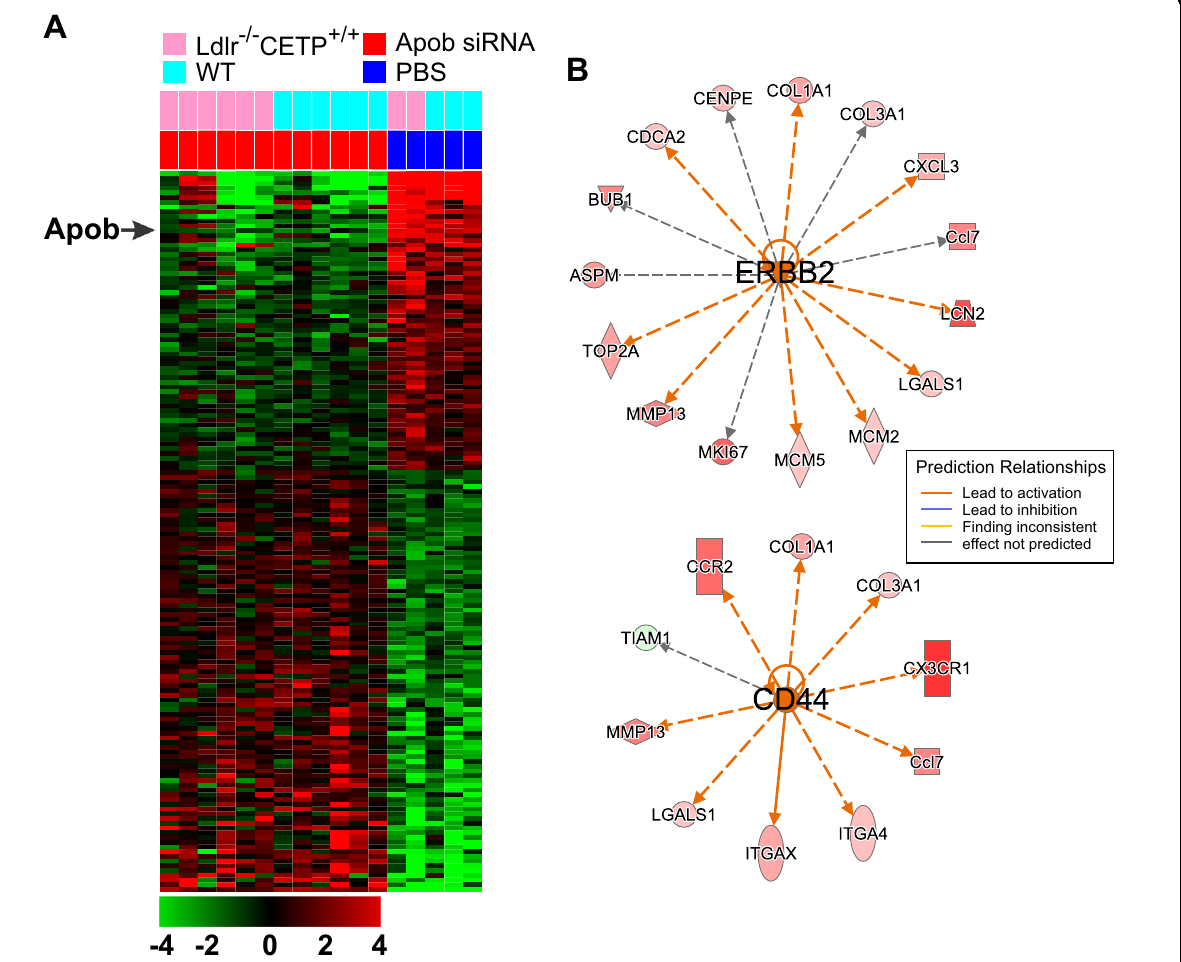
Fig. 1 Apob-associated gene expression signature in mouse livers. a Gene expression data were collected after treatment of mice with two siRNAs speci fi c for Apob or with phosphate-buffered saline (PBS) as the control. The expression of 152 genes was signi fi cantly altered (1.5-fold difference, P < 0.005) by silencing of Apob expression in mouse livers regardless of the genetic background and difference in siRNAs. Ldlr − / − CETP + / + indicates mice with the Ldlr − / − mutation and the human CETP + / + transgene under the human APOA1 promoter. WT indicates wild type. The data are presented in matrix format in which rows represent individual genes and columns represent tissue. Each cell in the matrix represents the expression level of a gene feature in an individual tissue. Red re fl ects relatively high expression and low re fl ects relatively low expression levels, as indicated in the scale bar (log 2 -transformed scale). Gene expression data are available in the Gene Expression Omnibus database (GSE23088). b Network analysis with Apob signature genes revealed that many of the genes were downstream targets of ERBB2 and CD44. Genes are color-coded according to the Apob siRNA/PBS ratio. Red represents relatively high expression in Apob-silenced liver and green represents relatively low expression in Apob-silenced